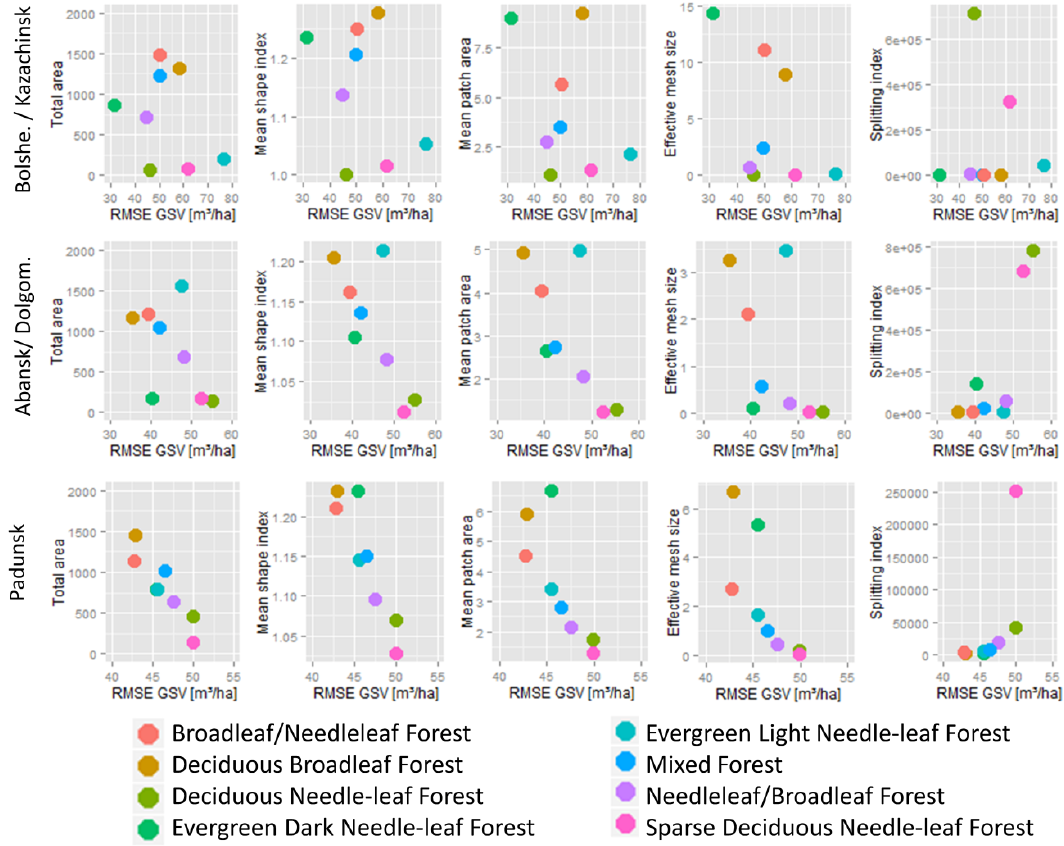
Figure 9. Scatterplots of landscape metrics derived from the MODIS land cover map and class-specific GSV RMSE between ASAR and PALSAR GSV